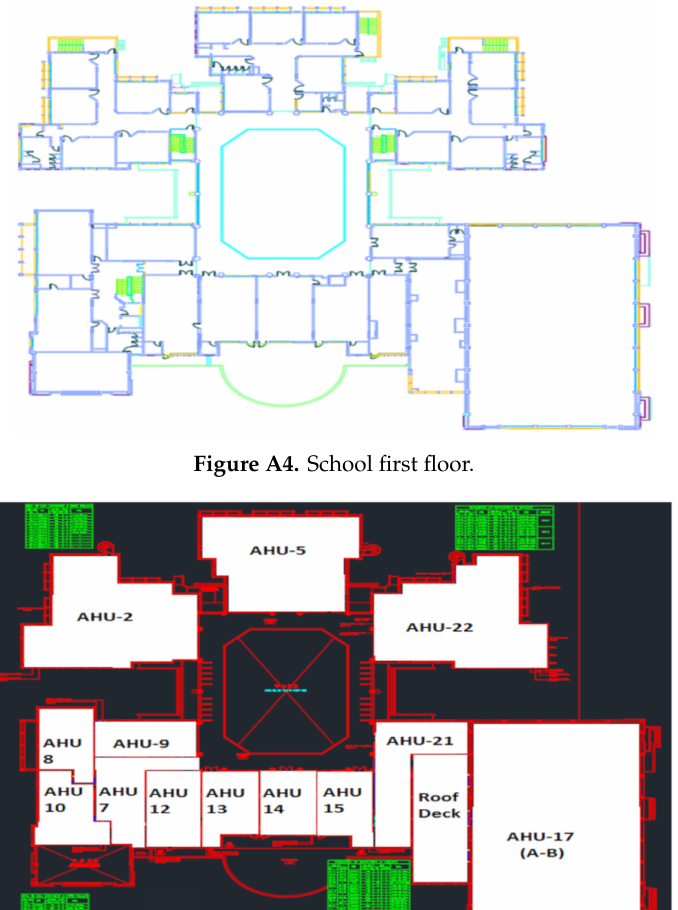
Figure A5. Air handling units in first